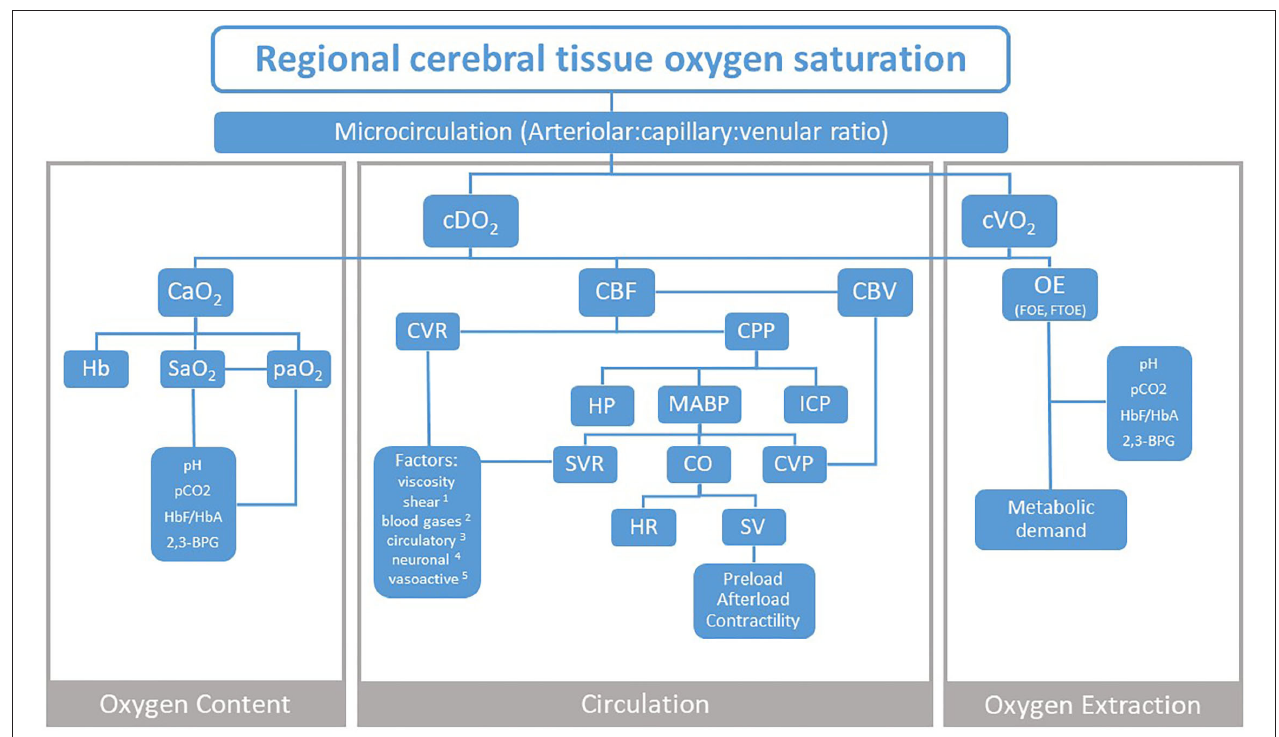
FIGURE 1 | Three physiological components that influence NIRS measurement of regional cerebral tissue oxygen saturation. cDO2, cerebral oxygen delivery; cVO2, cerebral oxygen consumption; CaO2, arterial oxygen content; CBF, cerebral blood flow; CBV, cerebral blood volume; CVR, cerebral vascular resistance; CPP, cerebral perfusion pressure; OE, oxygen extraction; FOE, fractional oxygen extraction; FTOE, fractional tissue oxygen extraction; Hb, hemoglobin; SaO2, arterial oxygen saturation; paO2, arterial partial oxygen pressure; pCO2, partial carbon dioxide pressure; HbF/HbA, fetal to adult hemoglobin ratio; 2,3-BPG, 2,3-biphosphoglycerate; HP, hydrostatic pressure; MABP, mean arterial blood pressure; ICP, intracranial pressure; SVR, systemic vascular resistance; CO, cardiac output; CVP, central venous pressure; HR, heart rate; SV, stroke volume. Factors 1 shear stress and stretch; 2 paCO2, paO2; 3 glucose, adrenaline, ATII- angiotensin II, adenosine; 4